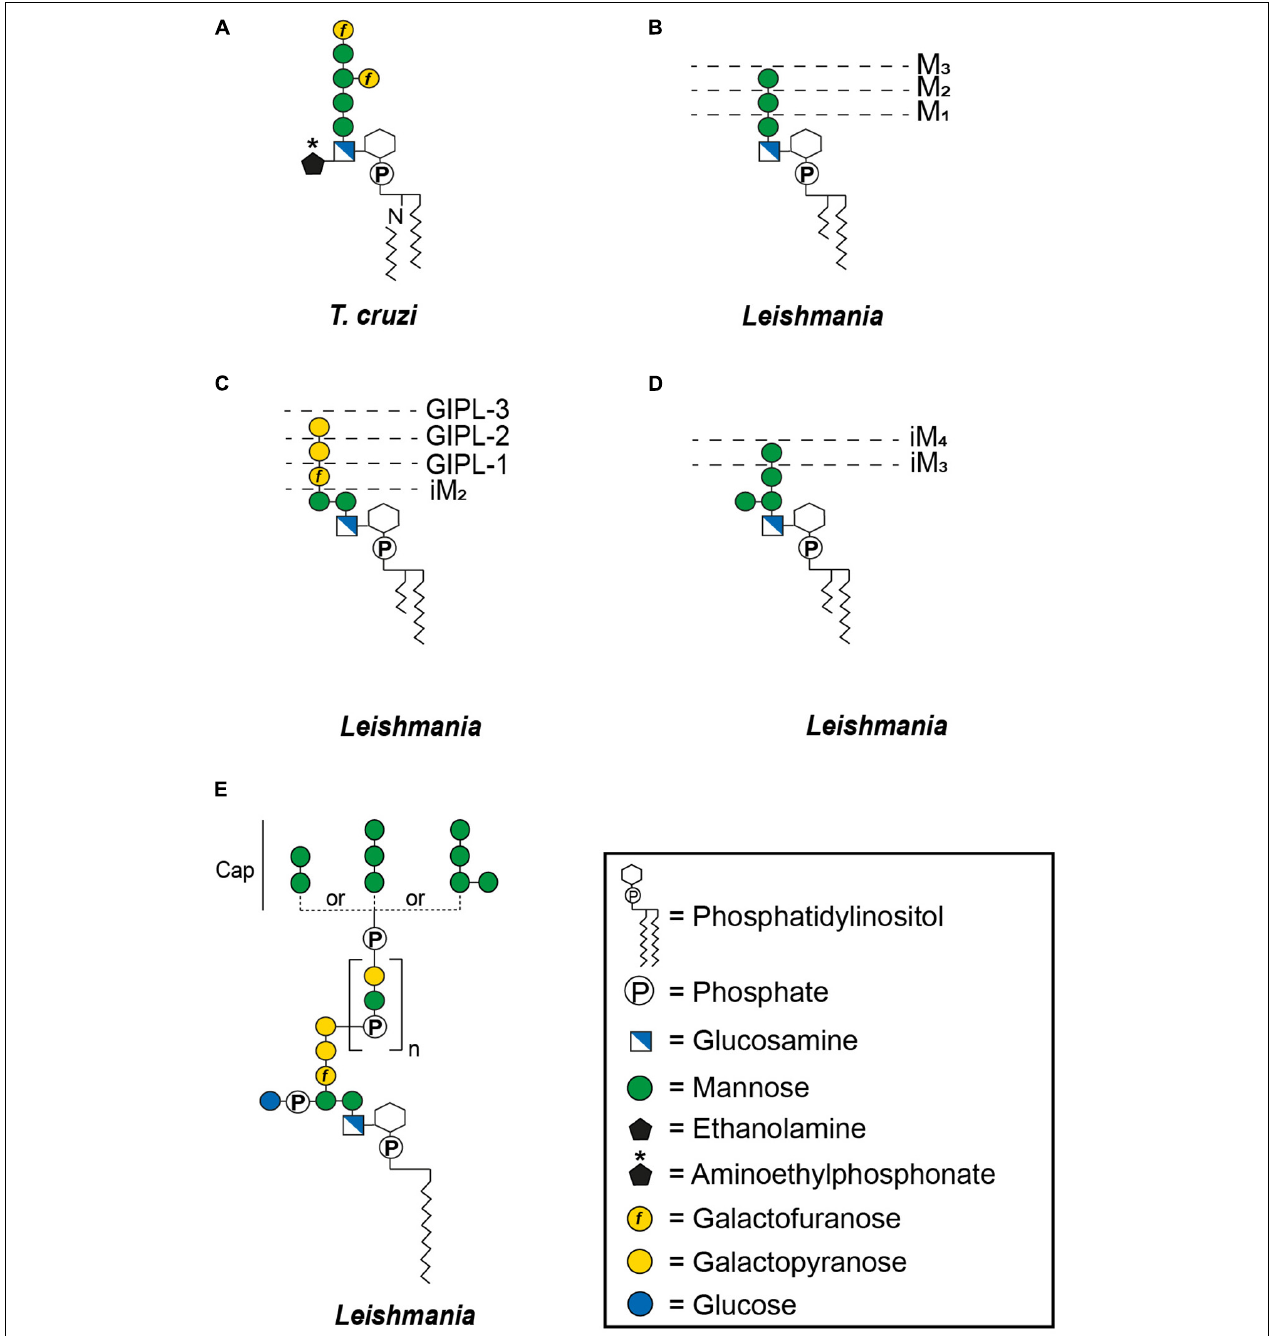
FIGURE 2 | General structures of free GPIs (GIPLs) and LPGs. The dashed lines indicate smaller GIPL species in Leishmania (McConville and Ferguson, 1993). M X indicates the number of mannoses and iM the unusual α 1-3 binding of these mannoses. The number of phosphosaccharide repeats (n) of Leishmania LPGs is stage and species specific (Forestier et al., 2014). (A) Trypanosoma cruzi Type-1 GIPL, (B) Leishmania Type-1 GIPLs, (C) Leishmania Type-2 GIPLs, (D) Leishmania hybrid GIPLs, and (E) Leishmania LPGs.